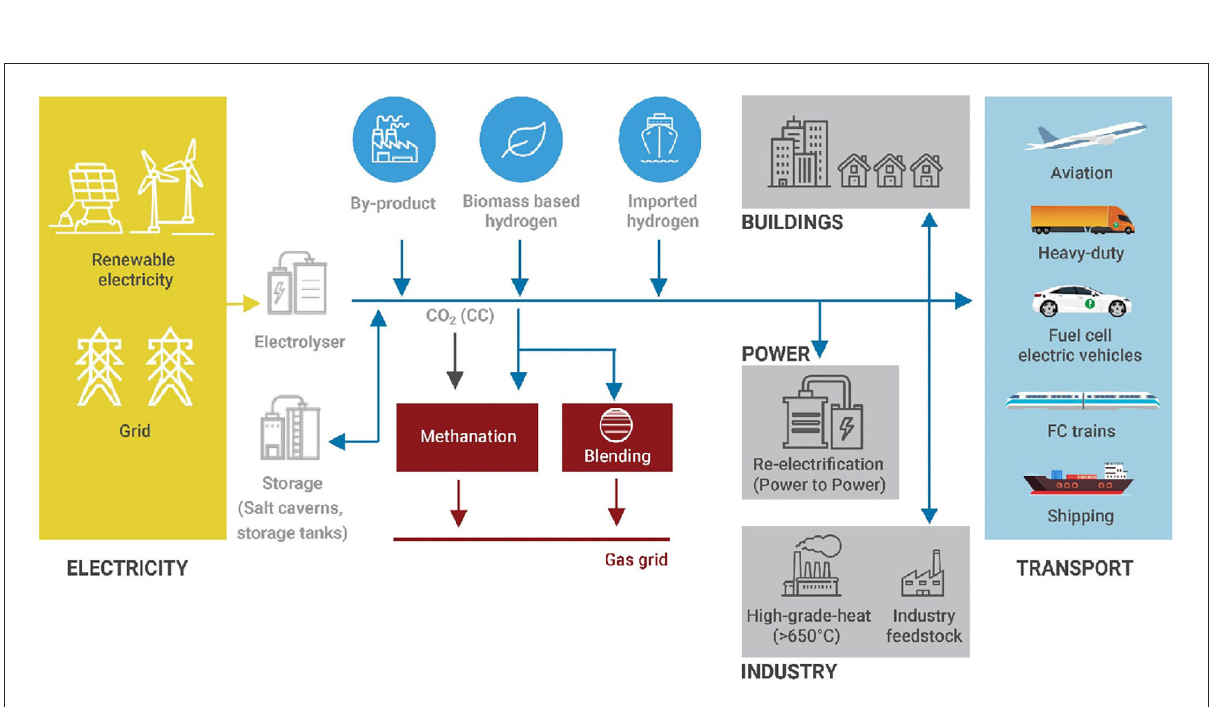
FIGURE4 Renewable power-to-hydrogen architecture (Irena,